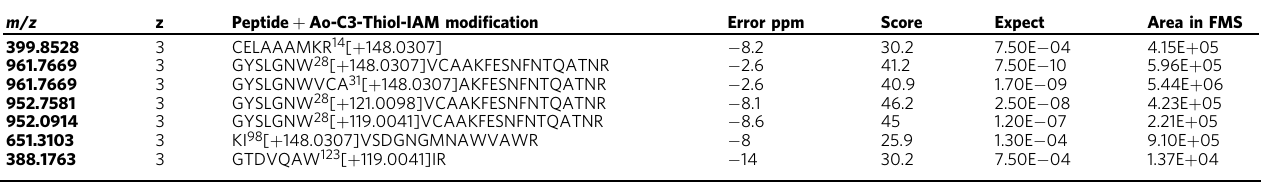
Table 1 List of oxidized peptides identi fi ed in MCO-lysozyme sample labeled with Ao-C3-Thiol-IAM after degradation of the Au 15 SG 12 -Ao NCs, using Protein Prospector.